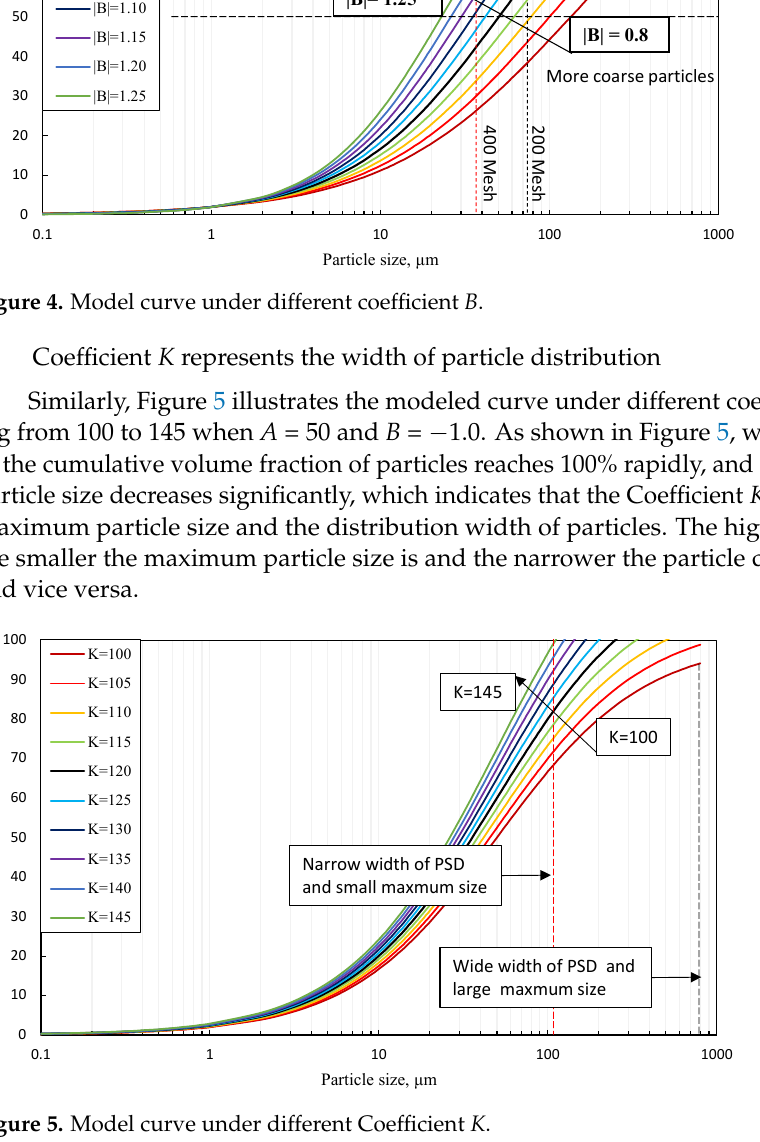
Table 2. Tailings sample PSD model and coefficients .